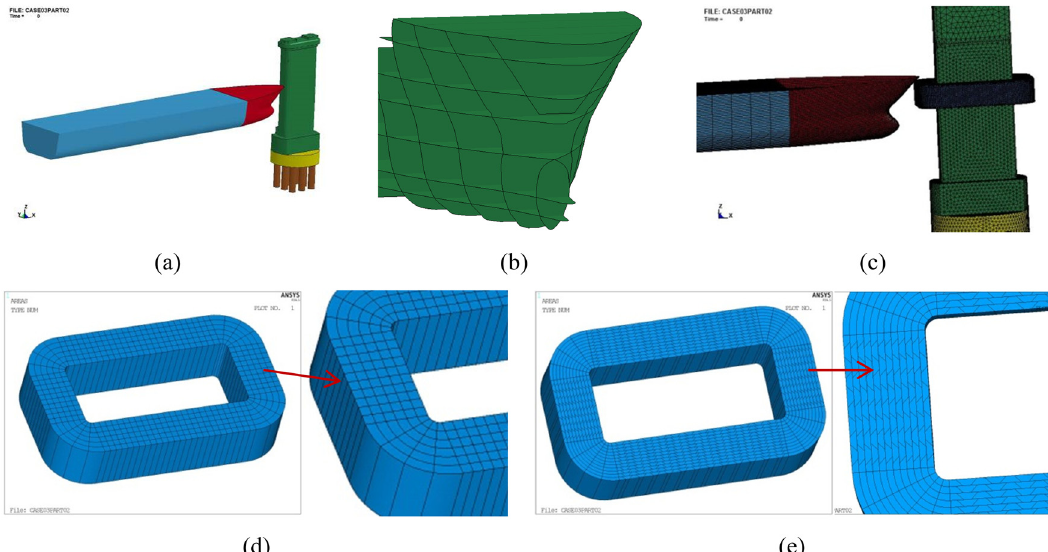
Figure 21: Numerical model of ship impact on bridge and composite anti - collision device: ( a ) ship – pier collision, ( b ) internal structure of ship bow, ( c ) ship – pier collision with anti - collision s device, ( d ) the composite anti - collision device and ( e ) the composite anti - collision device with 45 trapezoid space lattice webs.